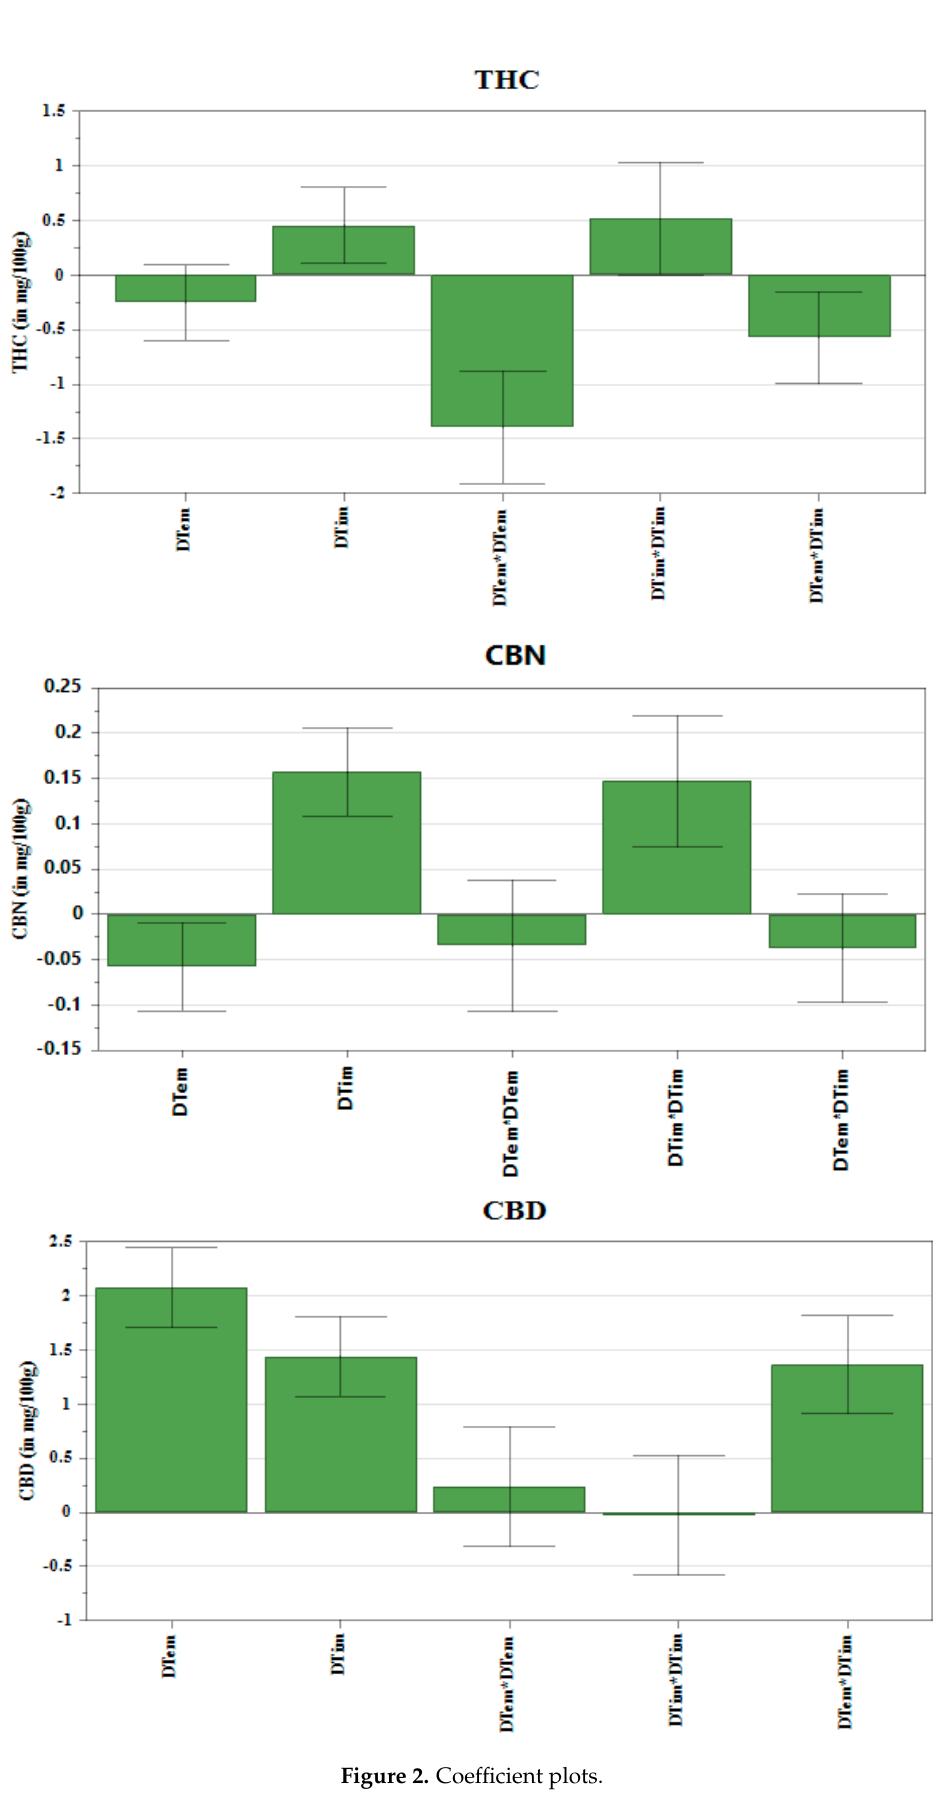
Figure 2. Coefficient plots.